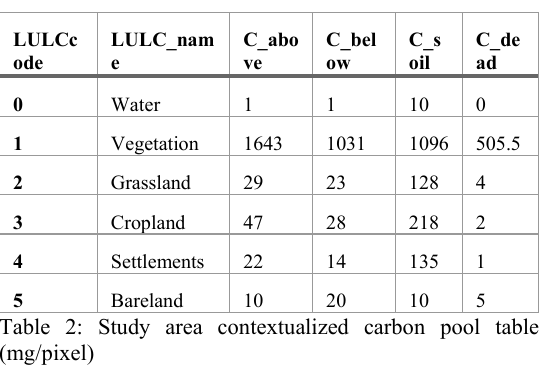
Table 2: Study area contextualized carbon pool table (mg/pixel)